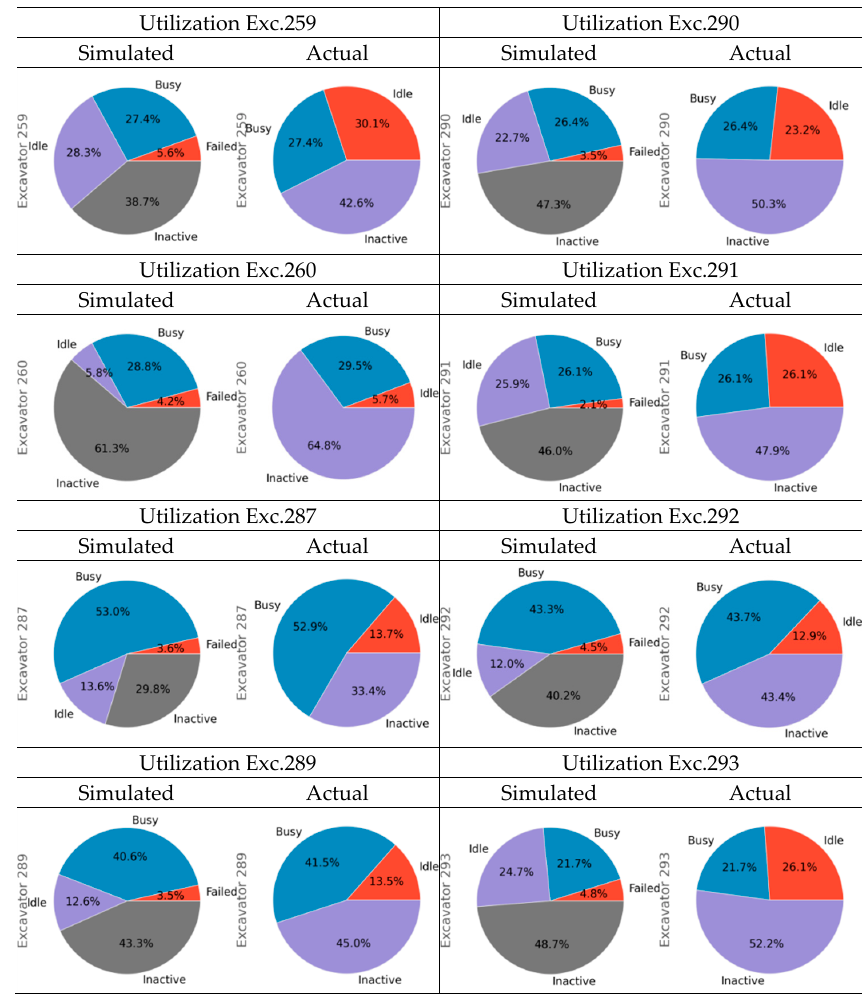
Figure 23. Utilization of the equipment in the form of pie charts.